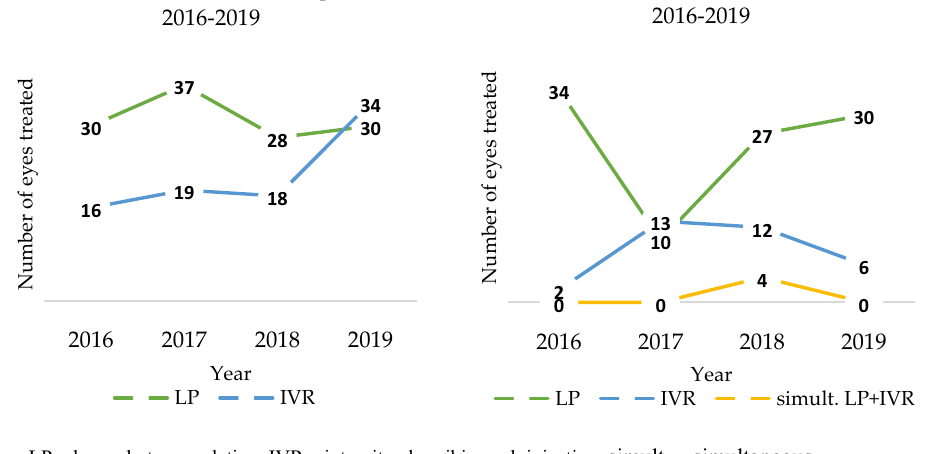
Figure 3. First-line treatment: ( a ) in inborn patients in the years 2016–2019; ( b ) in outborn patients in the years